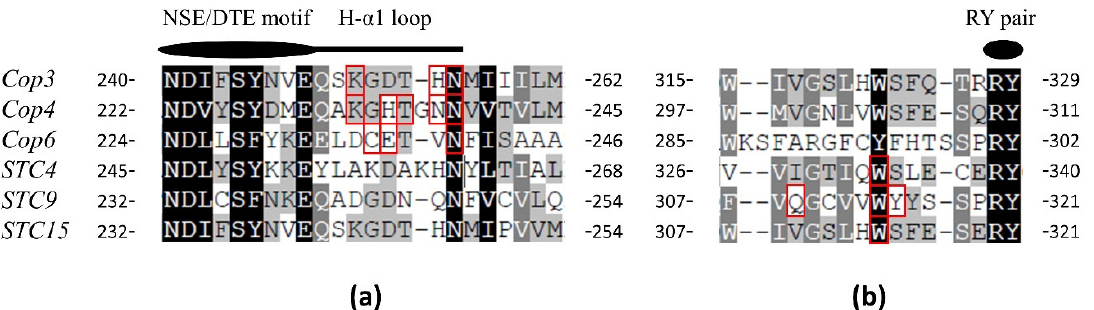
Figure 5. ( a ) Comparison of the conserved regions of H- α 1 loop and NSE/DTE motif. ( b ) Comparison of conserved regions of the RY Pair to the Thirteen Positions Upstream of the RY Pair. The MUSCLE algorithm was used to compare the following protein sequences: Cop3 (XP_001832925), Cop4 (XP_001836356), Cop6 (XP_001832549) in Coprinopsis cinerea ; STC4 (KAH0582448), STC9